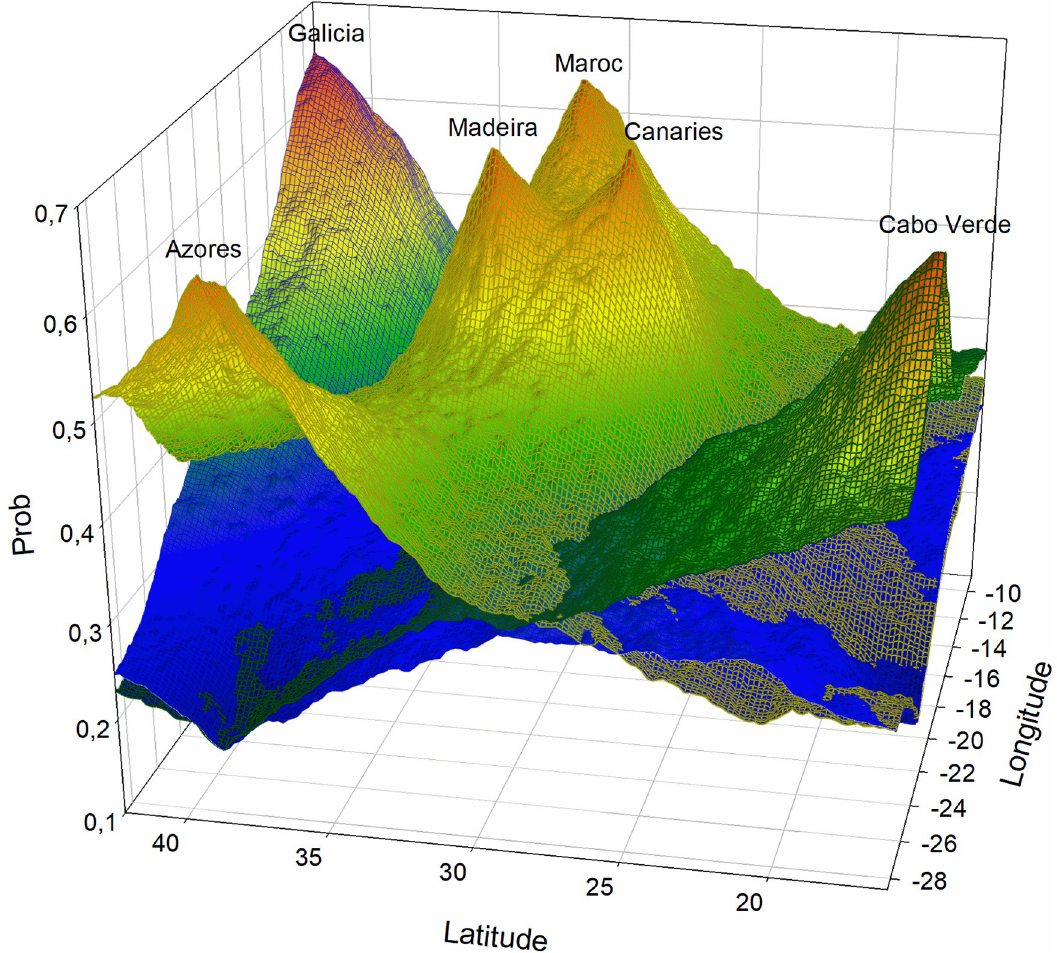
Fig 3. Probabilistic topography for assigning northeastern Atlantic Octopus vulgaris to clusters using Geneland. Mesh colors: blue (cluster 1), yellow (cluster 2), green (cluster 3). Probability values are depicted in a gradient from high (red) to low (blue).